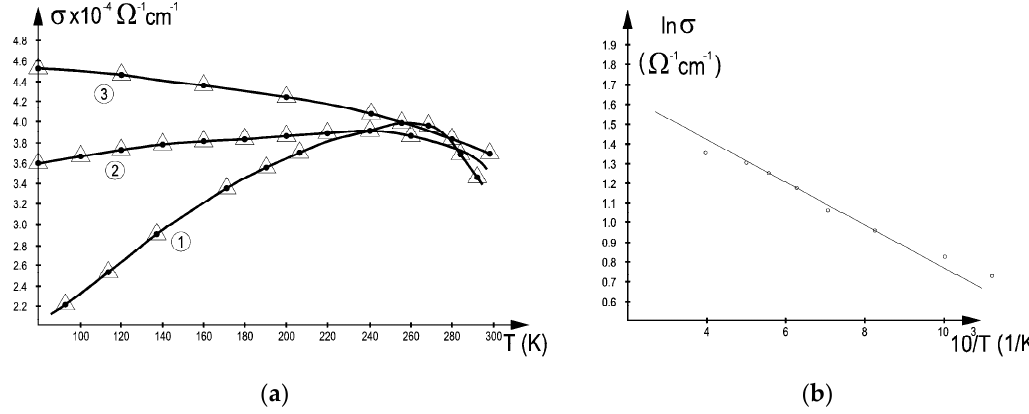
Figure 4. ( a ) Temperature dependent electrical conductivity for the LaNi 5 films of thickness (1) 68 nm (2) 110 nm and (3) 180 nm. The thick line is a guide for the eye, ( b ) Richardson plot of conductivity σ (1) from ( a ), curve (1).